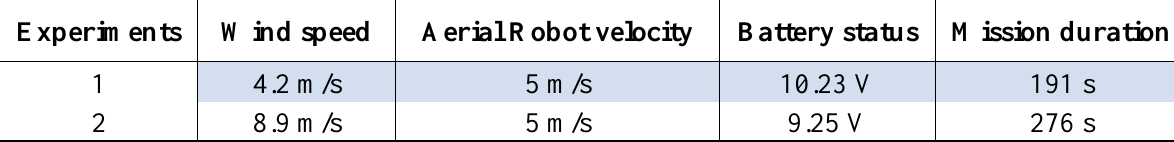
Table 4. The two experimental sets summed up focusing in the mission time and battery consumption. Experiments Wind